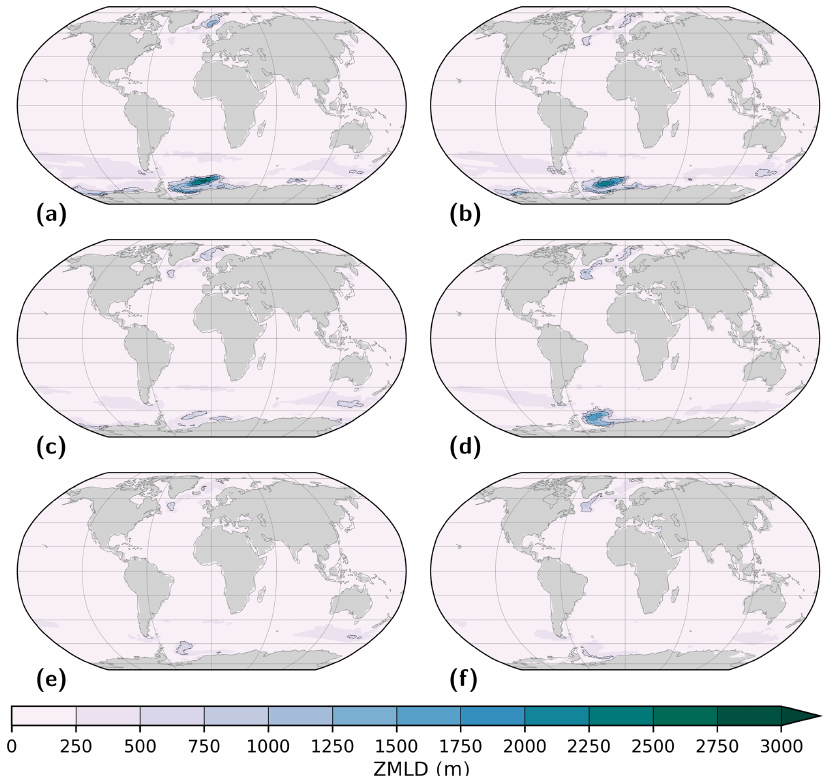
Figure 19. Annual mean depth of the mixed layer in the ocean (ZMLD, in metres). The ZMLD is defined by an increase of 0.125kgm − 3 in seawater density in comparison to the uppermost ocean layer. Shown are (a) E280, (b) Eoi280, (c) E400, (d) Eoi400, (e) E560, and (f) Eoi560. Contours given in intervals of 500m, starting at 500m. Grey shading illustrates the land–sea